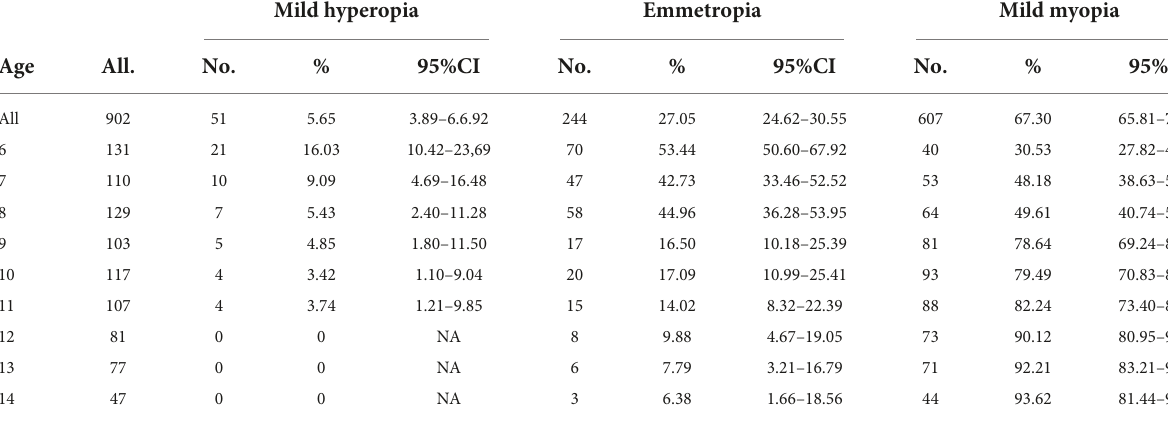
TABLE 1 The prevalence of mild hyperopia, emmetropia, and mild myopia children of 6–14 years of age.